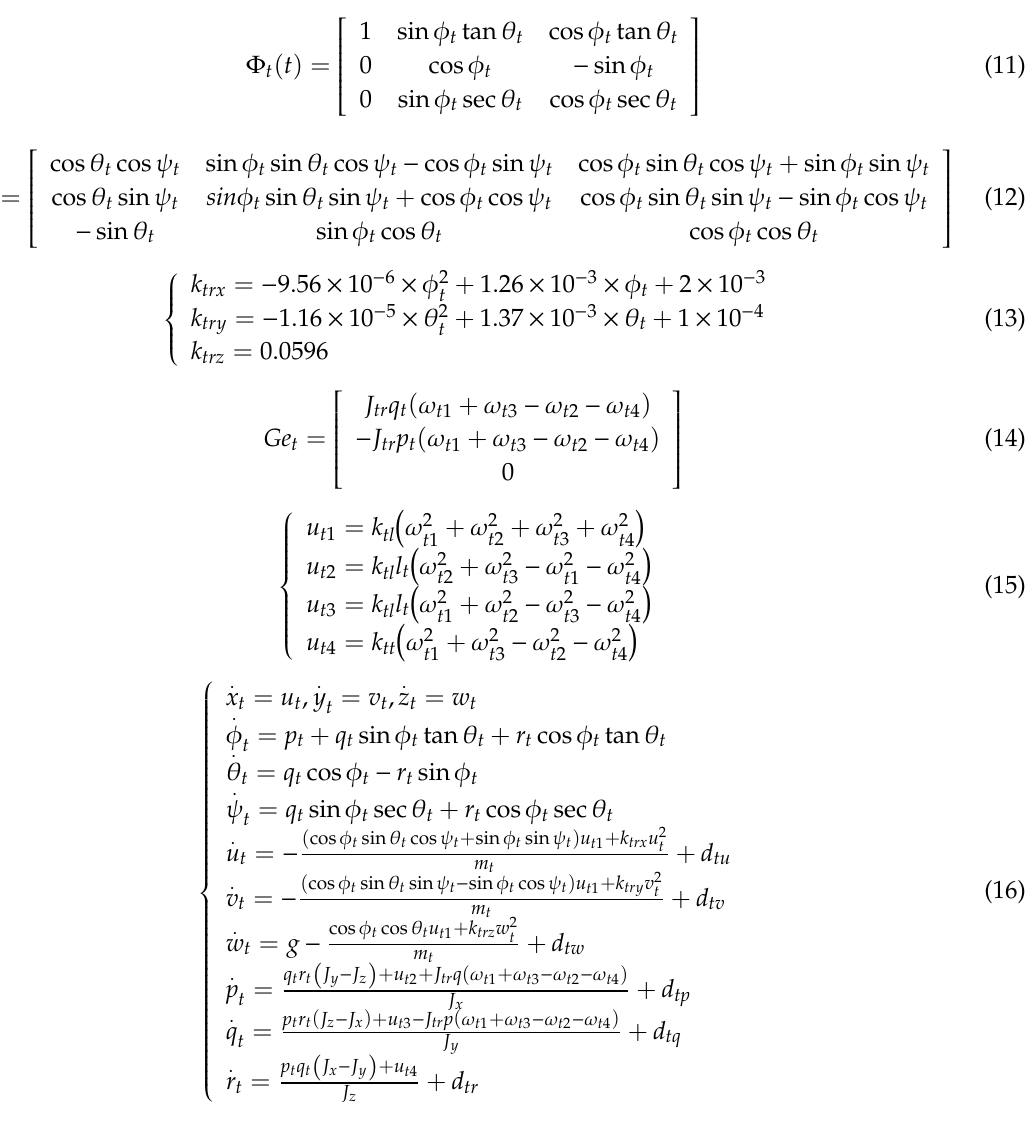
Table 2. Quadcopter